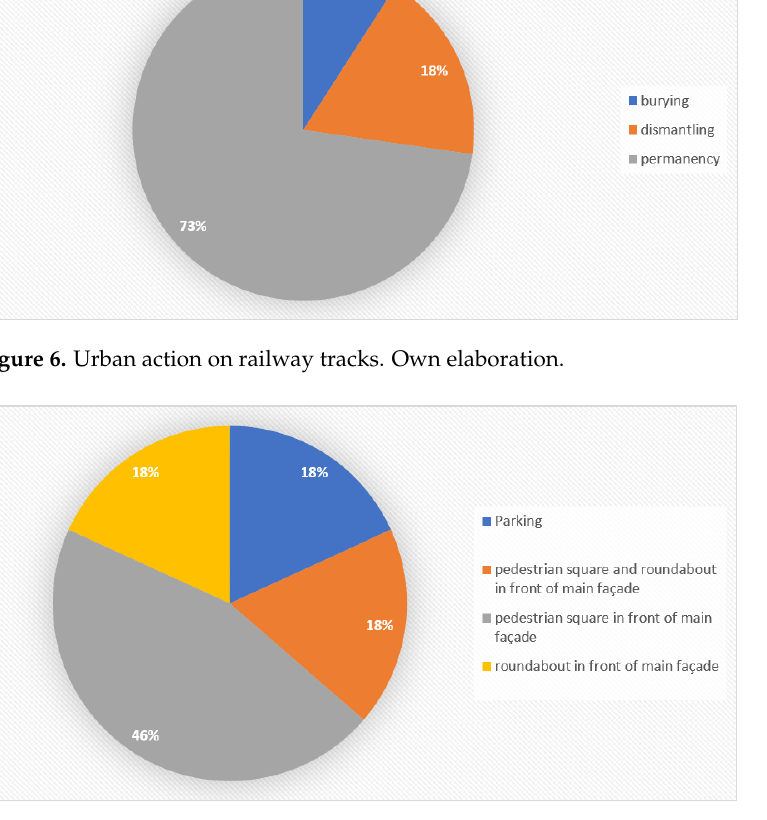
Figure 7. Station public space. Own elaboration.